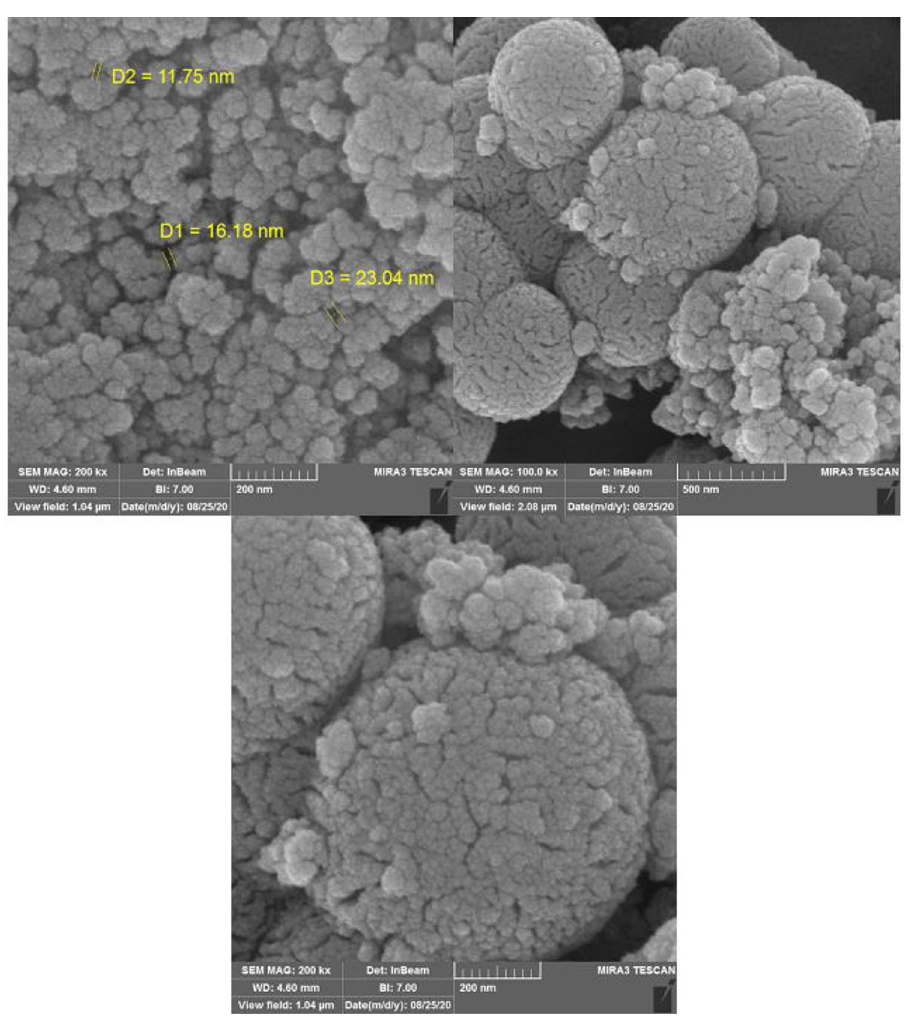
Figure 14. SEM images of